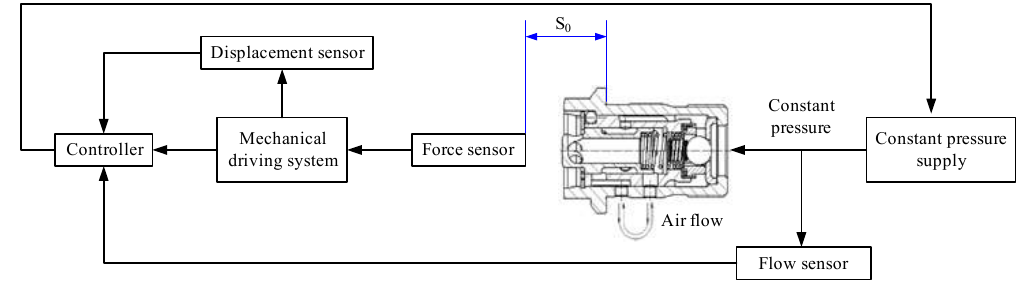
Figure 6. Testing scheme for the test system.